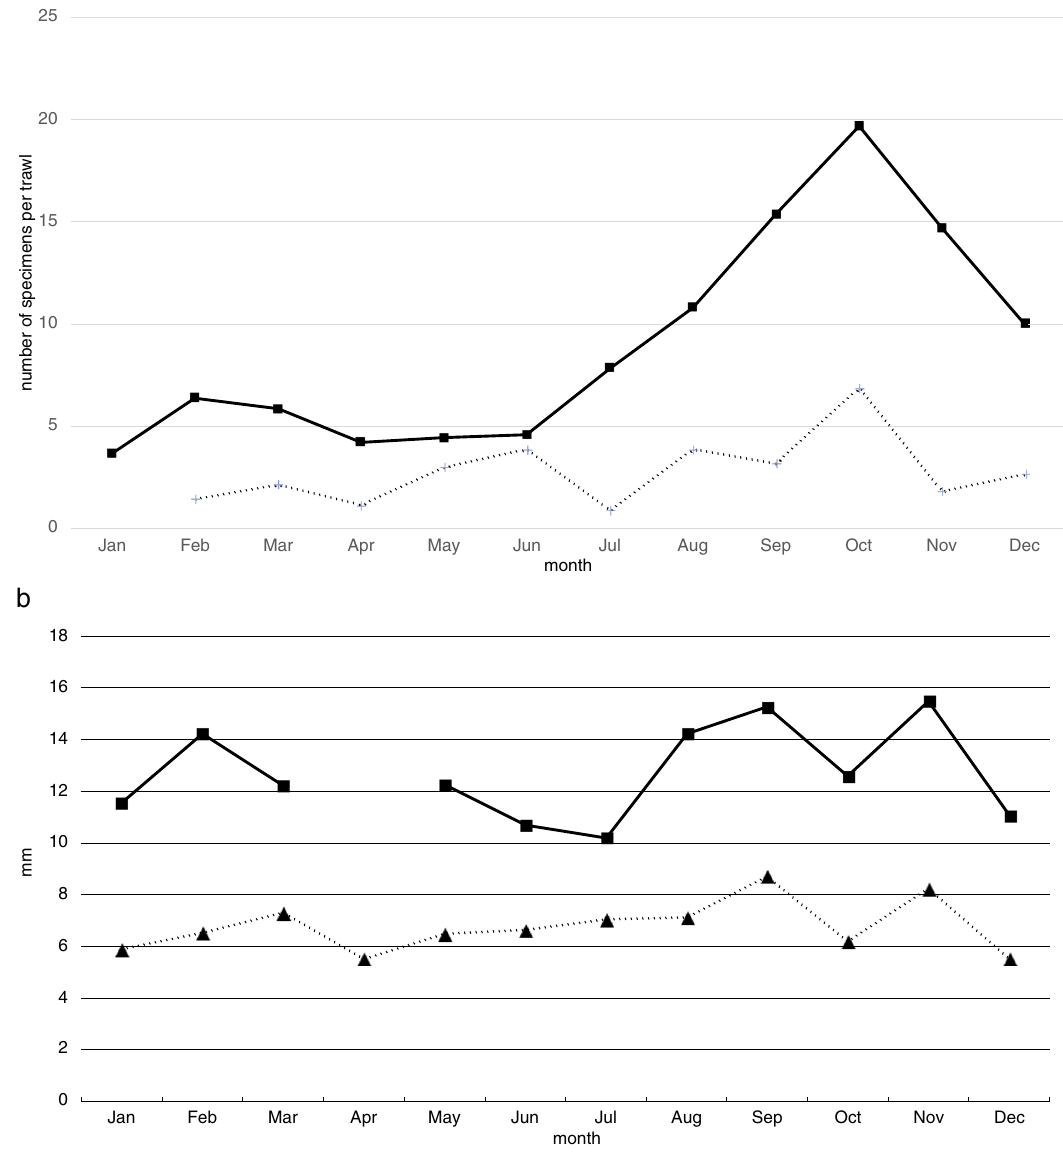
Fig. 1 Monthly collections of Xenoturbella bocki . a Number of collected specimens per trawl. b The average length of collected animals. In the graphs, solid lines show specimens collected off Skar in 2006 ( n = 590), and dotted lines show specimens collected off Lysekil in 2005 ( n = 197), both locations situated within